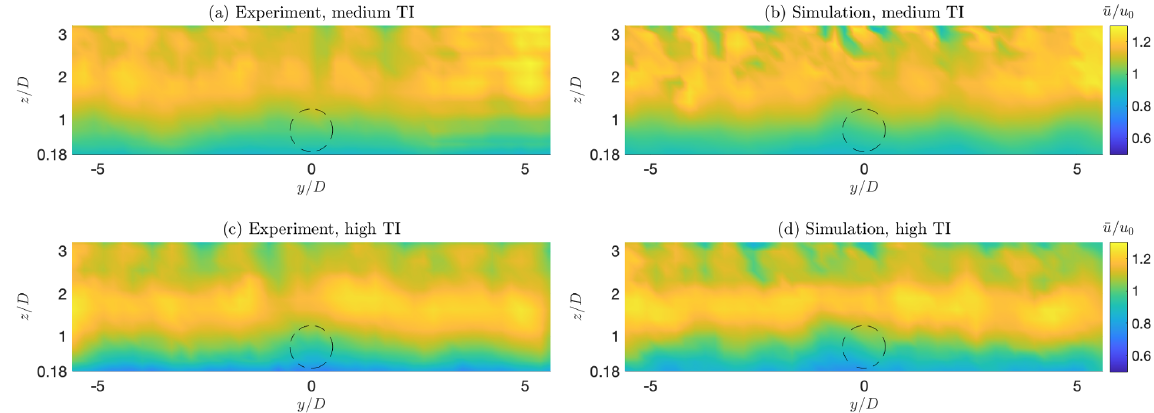
Figure 5. Streamwise velocity distribution on a cross section of the test chamber 3.59 D in front of the rotor. (a, c) Experimental measure- ments; (b, d) numerical simulations; (a, b) medium-TI case; (c, d) high-TI